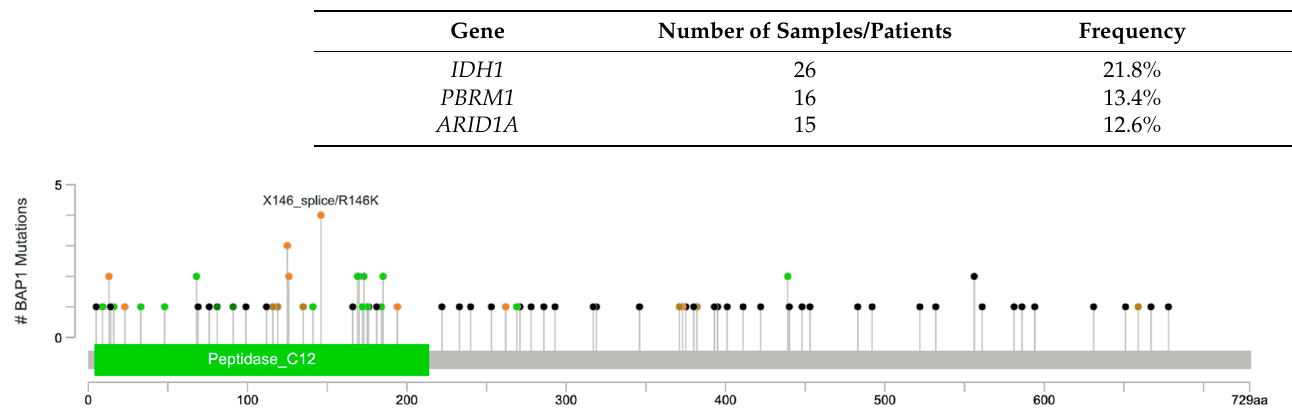
Table 2. The most commonly co-altered genes in BAP1-mutated iCCAs.